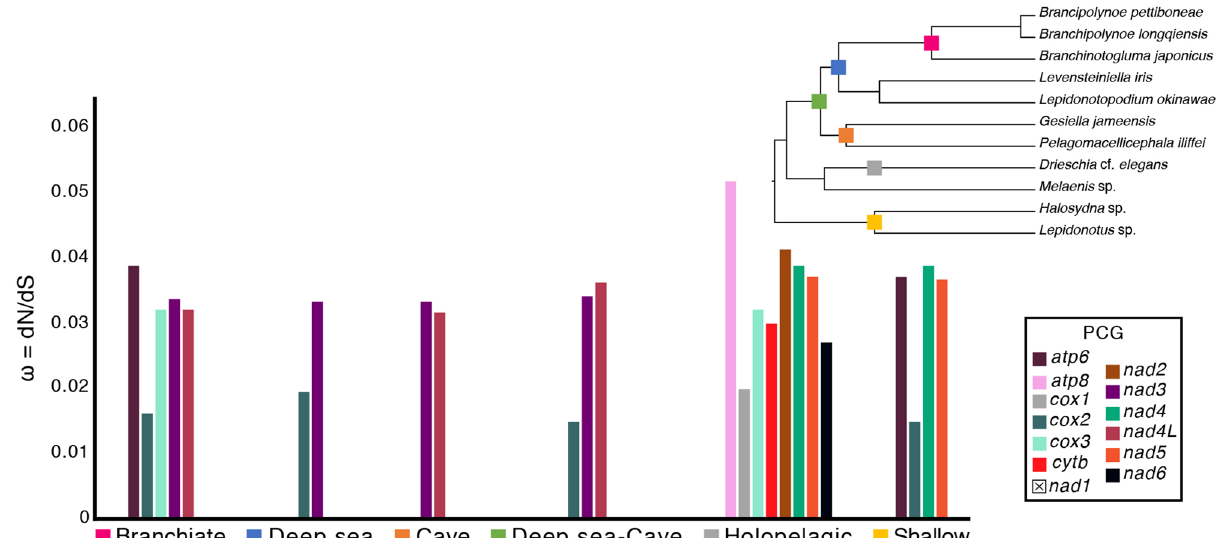
Figure 2. Estimated ratios (ω) of non-synonymous (d N ) to synonymous (d S ) substitution rates in Polynoidae for each of the individual 13 protein coding genes (PCGs) across selected nodes of the phylogeny in order to compare differences among habitats and lifestyles within Polynoidae. Missing bar graphs indicate that the log- likelihood (lnL) of the two-ratio model failed when compared against the lnL of the basic or null model